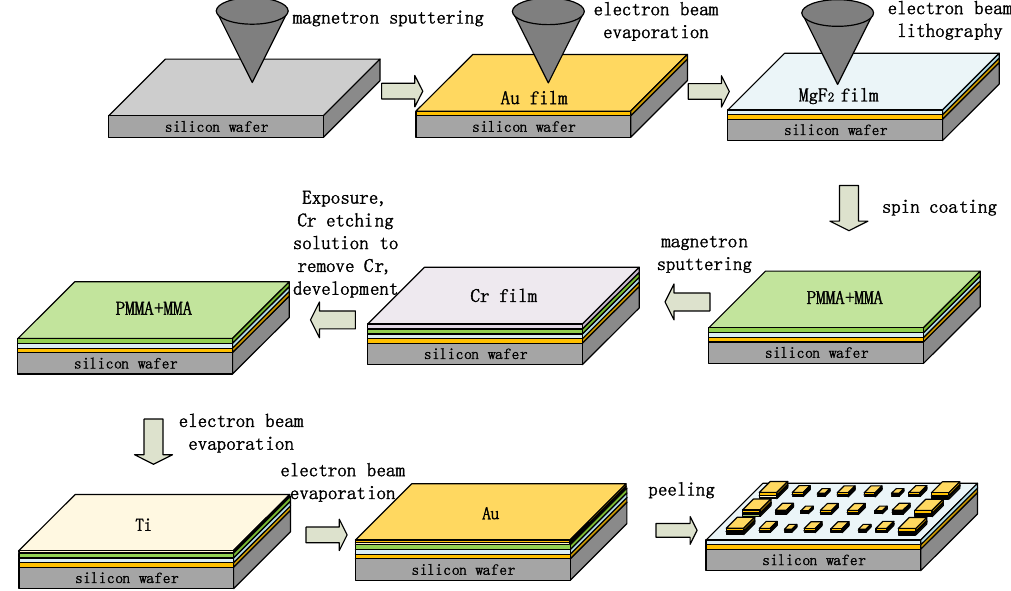
Figure 2. Process flowchart of the proposed metalens structure.